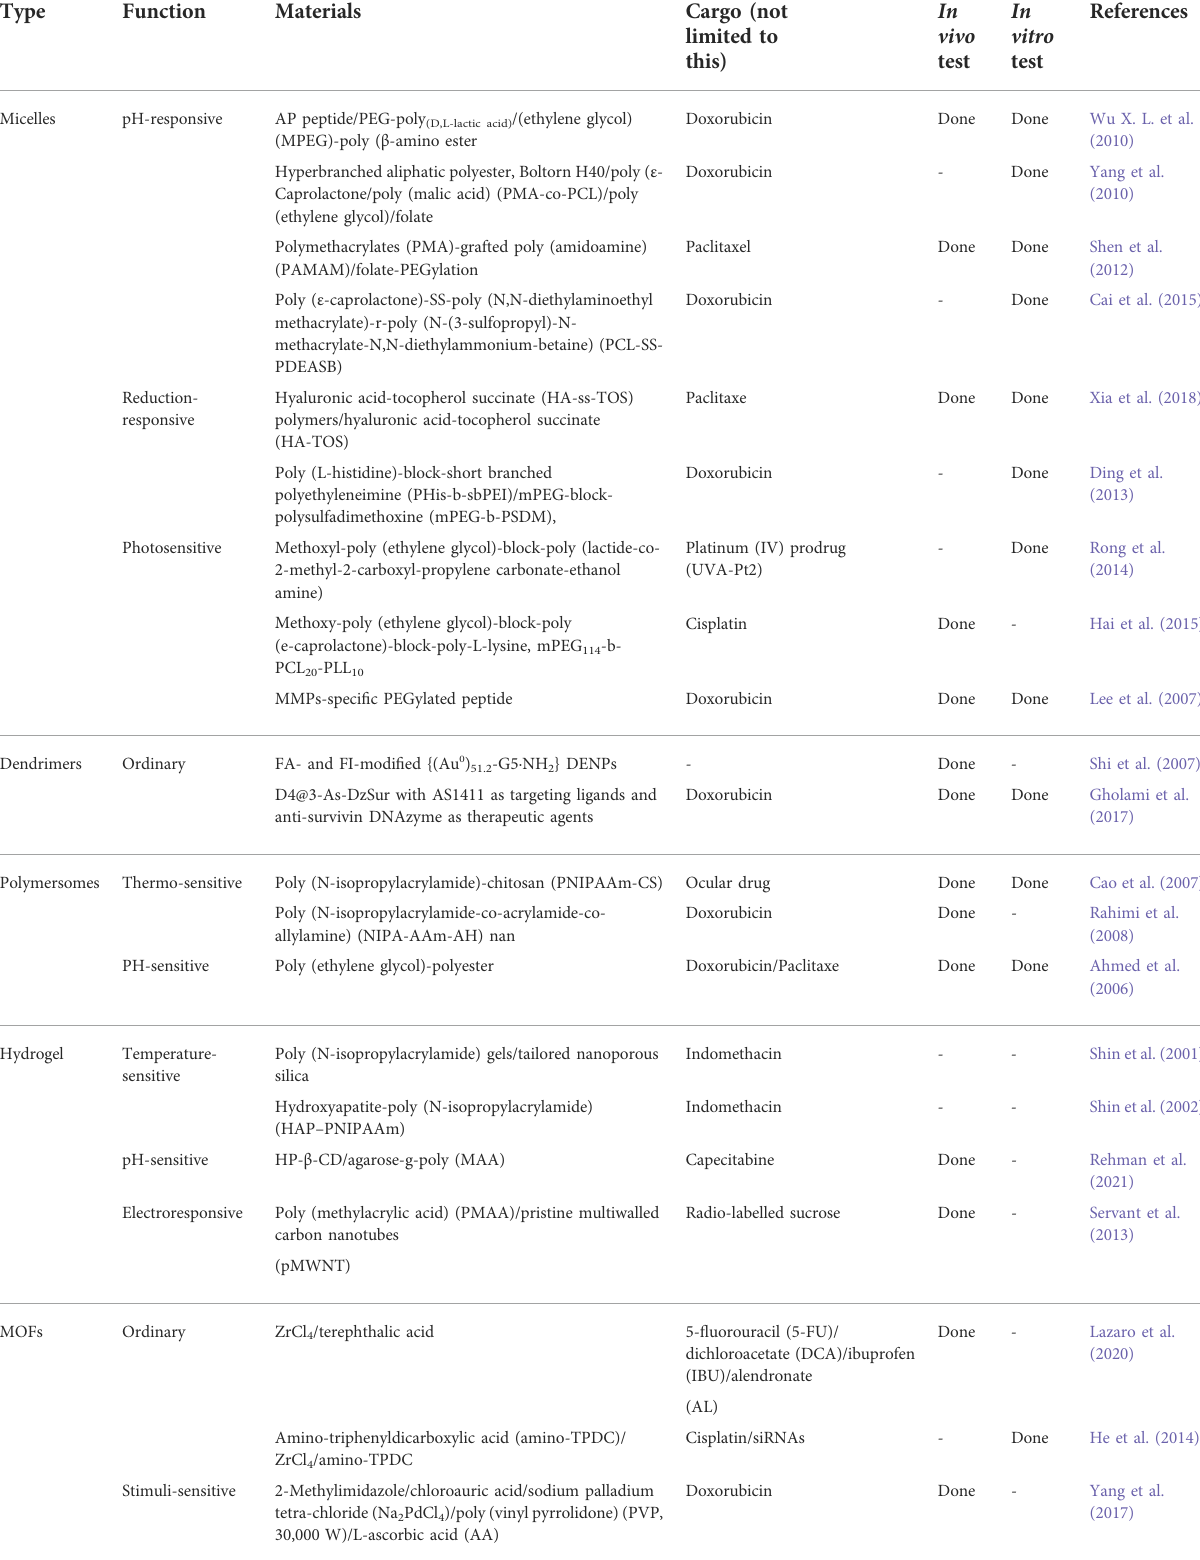
TABLE 1 The materials, cargo and in vivo /vitro test status of some typical